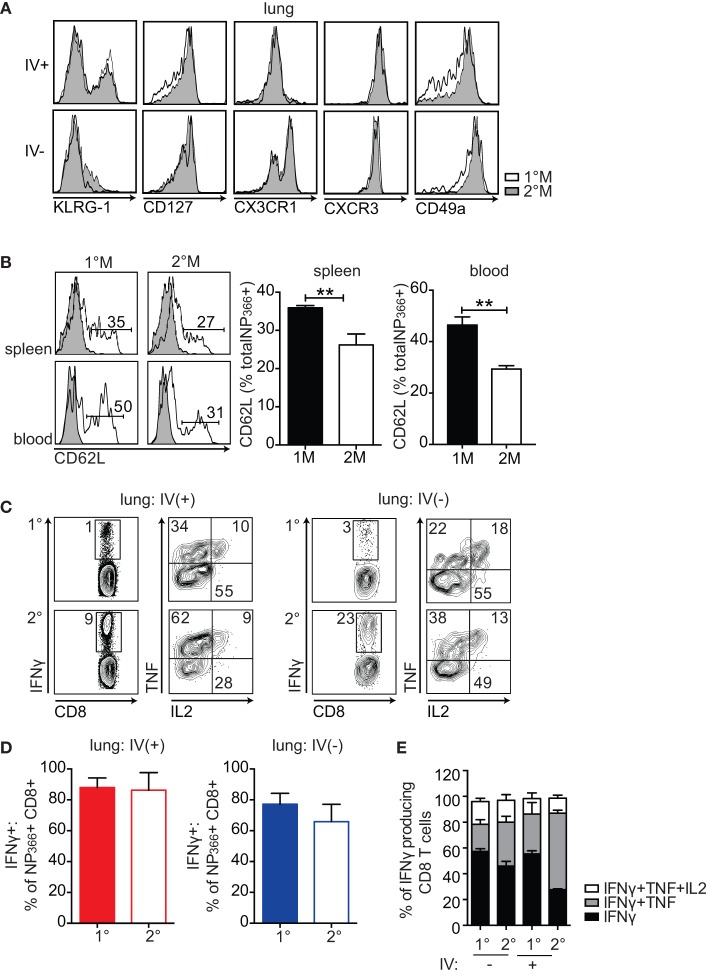
1°M and 2°M CD8 T cells display similar phenotypic and functional profile. (A) Representative plots (left-to-right) of KLRG-1, CD127, CX3CR1, CXCR3, and CD49a staining of NP366-specific CD8 T cells from lung vasculature (IV+) and lung parenchyma (IV−) of 1°M (white) and 2°M CD8 T cell-bearing mice (gray) performed 70–90 days post-last influenza A virus (IAV) infection. (B) Representative plots (left) and cumulative bar graphs (right) of CD62L expression evaluated in 1°M or 2°M NP366-specific CD8 T cells isolated from spleen (top panels) and blood (bottom panels) 70–90 days post-last IAV infection. Error bars represent mean ± SEM (n = 4 mice/group). Unpaired t test. **p < 0.01. Representative of 2 independent experiments. (C) Cells isolated from lungs of 1°M and 2°M CD8 T cell-bearing mice 70–90 days post-IAV infection were cultured ex vivo in presence of EL-4 cells coated with NP366 peptide. IV administration of CD45.2 3 min prior to sacrifice allowed for discrimination between lung vasculature and parenchyma. Production of IFNγ, TNF, and IL2 was assessed by intracellular staining. Representative plots of IFNγ (left) and TNF/IL2 staining (gated on IFNγ+; right) of ex vivo peptide-restimulated cells derived from lung vasculature (IV+) or lung parenchyma (IV−). (D) NP366-specific CD8 T cells were enumerated by tetramer staining performed on a separate sample from the same lung cell suspension, as activation of CD8 T cells induces downregulation of the TCR and does not allow for accurate enumeration. Percentage of 1°M and 2°M NP366-specific CD8 T cells derived from lung vasculature (IV+) or lung parenchyma (IV−) producing IFNγ as a response to ex vivo peptide restimulation (n = 4 mice/group). Representative of two independent experiments. Error bars represent mean ± SEM. Unpaired t test. No significant differences. (E) Cumulative data of single (black, IFNγ), double (gray, IFNγ + TNF), and triple (white, IFNγ + TNF + IL2) cytokine-producing CD8 T cells relative to the total IFNγ-producing CD8 T cells derived from lung vasculature (IV+) or lung parenchyma (IV−) of 1°M and 2°M CD8 T cell-bearing mice (n = 3 mice/group). Representative of three independent experiments. Error bars represent mean ± SEM. Multiple comparison two-way ANOVA. *p < 0.05, **p < 0.01, ***p < 0.001, ****p < 0.0001. Statistics: IFNγ 1°M (IV−)–2°M (IV+): *****, 2°M (IV−)–2°M (IV+): **, 1°M (IV+)–2°M (IV+): ***, IFNγ + TNF 1°M (IV−)–2°M (IV−): *, 1°M (IV−)–2°M (IV+): ****, 2°M (IV−)–2°M (IV−): ****, and 1°M (IV+)–2°M (IV+): ****.